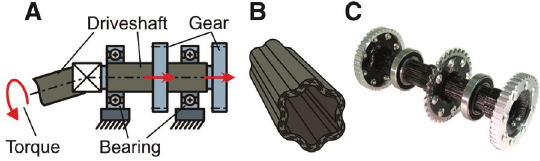
Figure 2 Concept for a modular driveshaft system with a profiled shaft body: complex drivetrain (A), linearly extruded shaft body (B), and demonstrator part